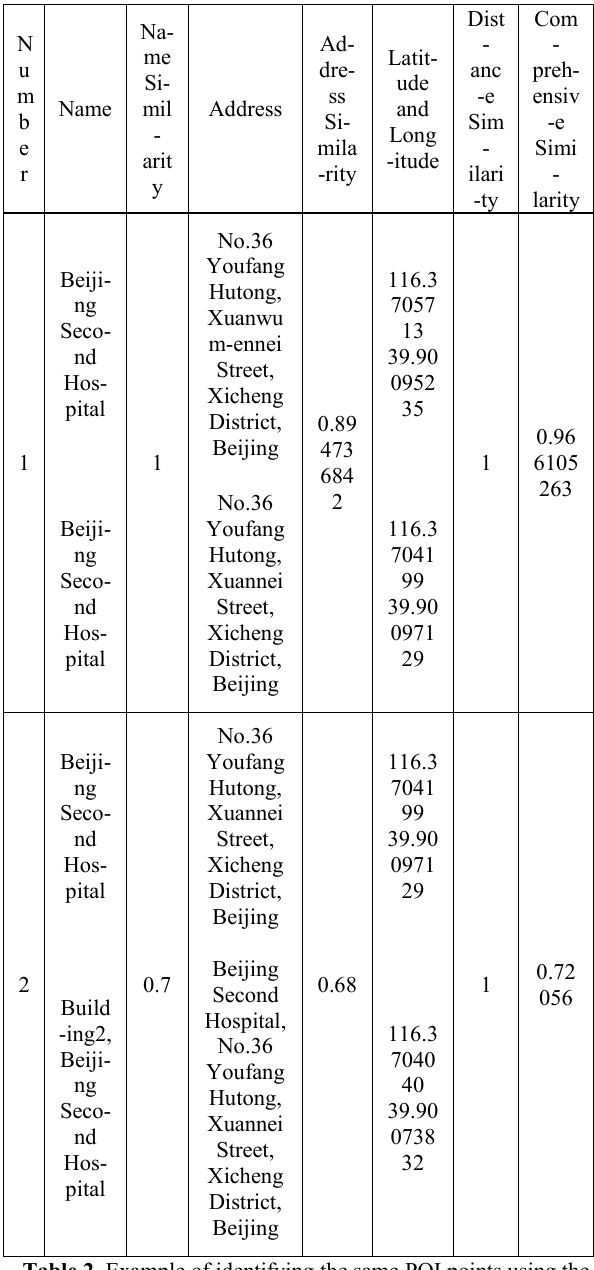
Table 2 . Example of identifying the same POI points using